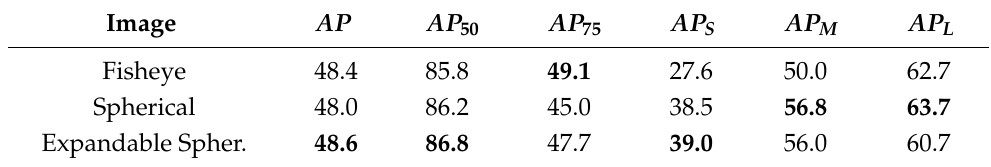
Figure 15. Cropped image of the detection result from different projection methods on YOLOv3-SPP. ( a ) Fisheye image; ( b ) Spherical image; ( c ) Expandable Spherical image. Table 13. Accuracy of different projections of YOLOv3-SPP model on Fisheye-Dongseongro.